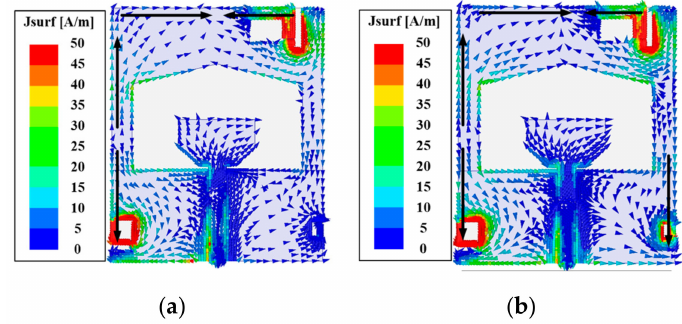
Figure 13. Simulated surface current distributions for multi-communication mode at 5.2 GHz. ( a ) Communication mode #4 (P2 & P3 ON); ( b ) Communication mode #7 (P2 & P3 & P4